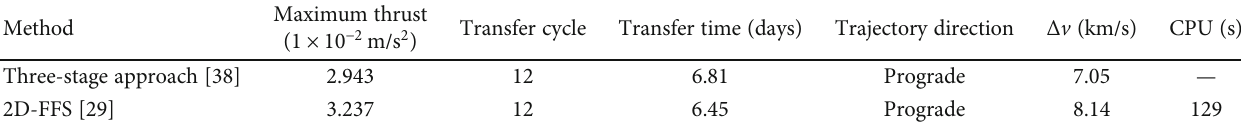
Table 9: Comparison of results of di ff erent methods [29, 38].